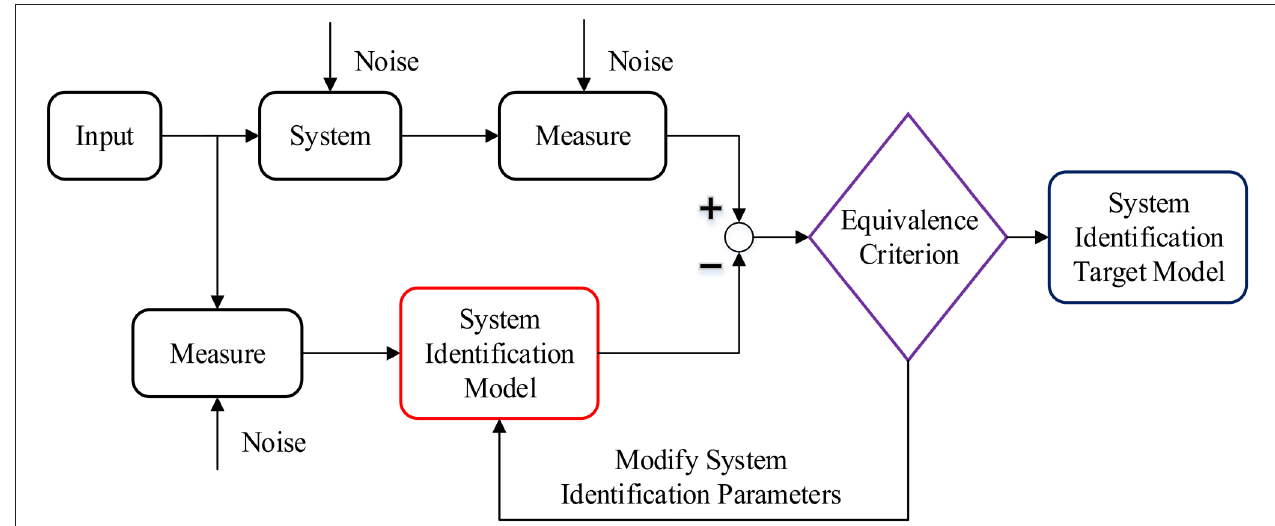
FIGURE 1 | A diagram of system